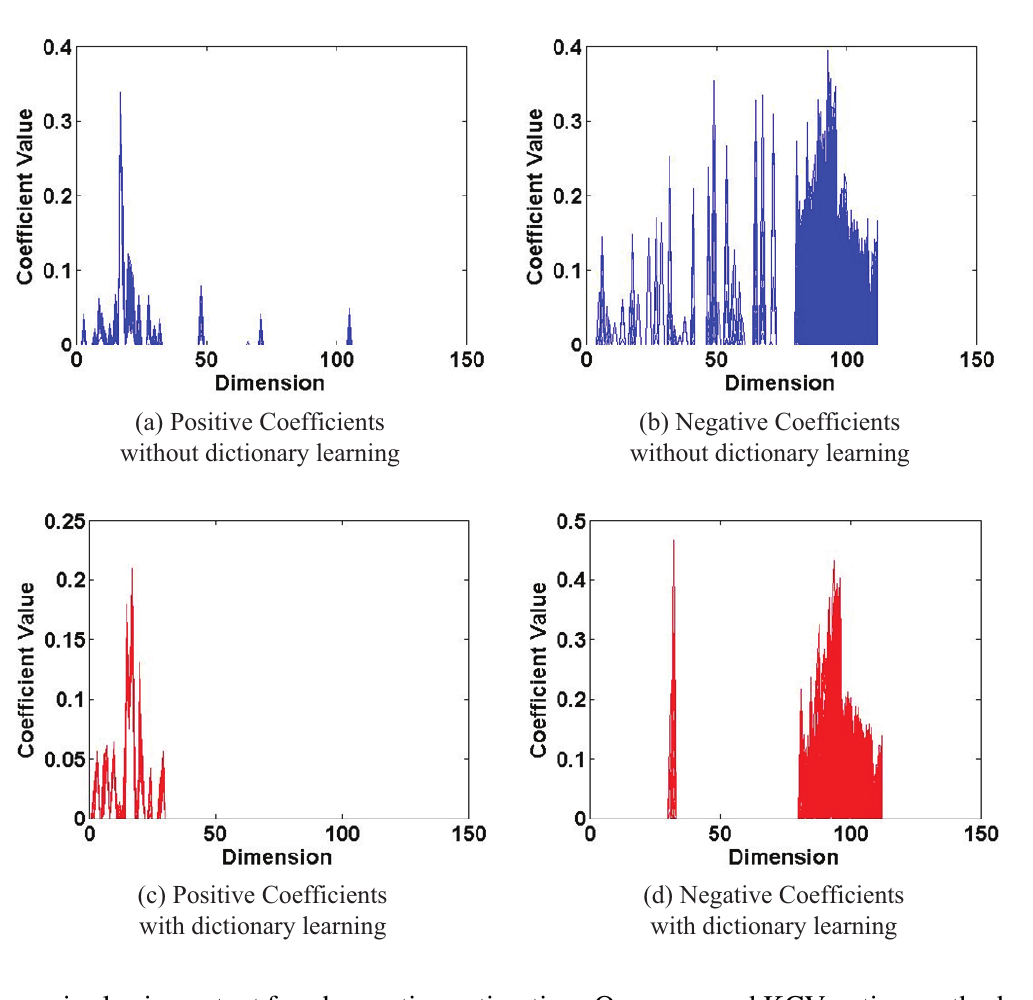
Figure 14. Coefficients of positive and negative samples in sequence Car 4 with/without dictionary learning. The parameter settings are the same with those in the experiments